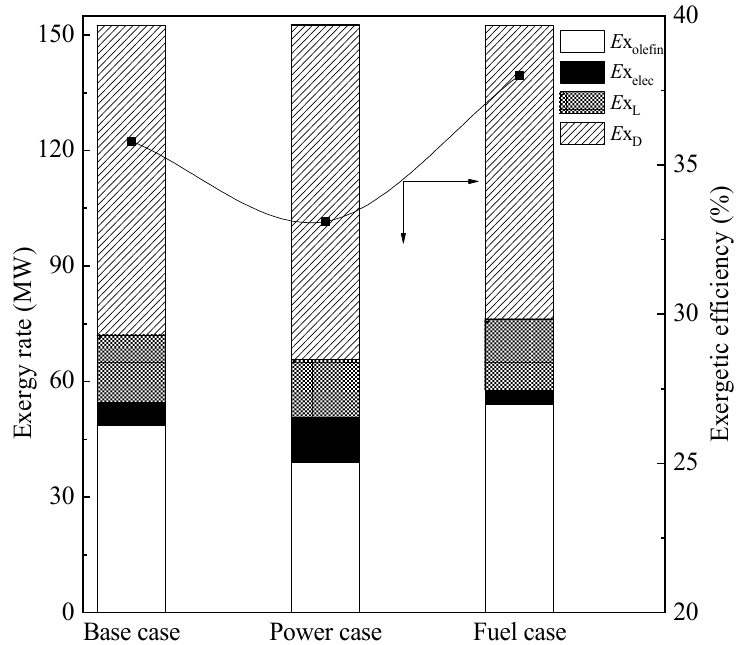
Figure 2. Exergy rates and exergetic efficiencies at the system level for each case. The exergy rate of light olefins increased from 48.7 MW to 54 MW when 20% synthe- sis tail gas is recycled. Together with the exergy rate of output electricity of 3.79 MW, the overall exergetic efficiency increased to 38% in the fuel case. Yet, it was still low compared with the other biofuel production systems. For example, microwave-assisted biomass py- rolysis showed an exergetic efficiency of 48.8% using corn stalk [36]. Using coke-oven gas and pulverized coke demonstrated 65% exergeitc efficiency toward coproduction of ole- fins and ammonia [37]. The efficiency was in the range of 37–44% for the bio-olefin system with biomass moisture content of 6.9 wt% [6]. However, the bio-FT system using biomass with 50 wt% moisture content presented low exergy efficiency of 24–27% [21]. Therefore, the moisture content of feedstock and the tandem process might have resulted in the low yield of light olefins and exergetic efficiency in this context. Besides, the precondition of power self-sufficiency also associates with the severe exergy destruction in the combus- tion units, it consequently decreased overall system efficiency [38]. Splitting 20% of the raw gasification gas for combustion enhanced the exergy rate of net output electricity to 11.6 MW at the expense of the low light olefin yield in the power case. Moreover, its internal exergy irreversibility was the maximum of 86.9 MW. At the same time, the exergy loss to the surroundings in the power gas is relatively low at 15.1 MW. It is seen that the input exergy of the subsystem decreases along with the conversion pathway in Table 5, which means exergy destruction from the tandem production of syn- gas, methanol and light olefin subsequently. Due to the introduction of the combustion effluent gas for drying, together with gasification steam, the input exergy rate of the gas- ification subsystem is above 175 MW in each case, which is higher than biomass input exergy of 150.9 MW. For the gas composition adjustment subsystem, the input exergy, including WGS steam, compression work, heat stream for sulphur removal and raw gas- ification gas, is also higher than biomass exergy in the base case and the fuel gas. However, it decreased to 127 MW in the power case due to the splitting of 20% raw gasification gas for combustion, rather than for syngas production.